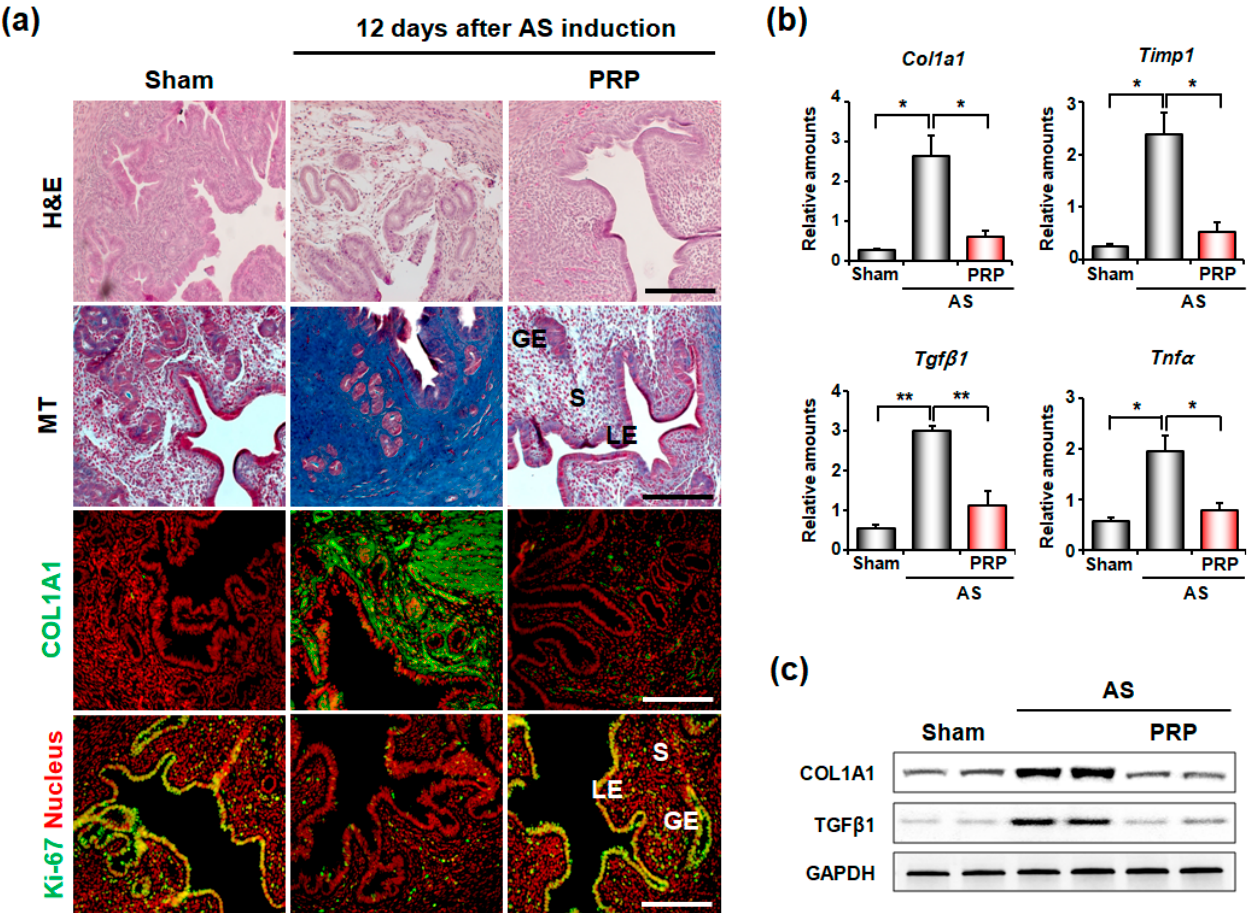
Figure 2. Intrauterine delivery of hPRP significantly reduces uterine fibrosis in mice with AS. ( a ) Histological analyses in AS uteri after intrauterine delivery of hPRP. Gross endometrial morphology and collagen deposition were evaluated by hematoxylin and eosin (H&E) staining and MT staining, respectively. Immunofluorescence staining of COL1A1 and KI-67 was performed to evaluate levels of collagen and proliferating cells, respectively. Green and yellow colors indicate COL1A1 and KI-67-positive cells, respectively; red indicates nuclei in uterine cells. LE, luminal epithelium; GE, glandular epithelium; S, stroma. Scale bar, 50 µ m. ( b , c ) Real-time RT-PCR and Western blotting analyses for expression levels of fibrosis-related factors after hPRP treatment. * p < 0.05, ** p < 0.01.